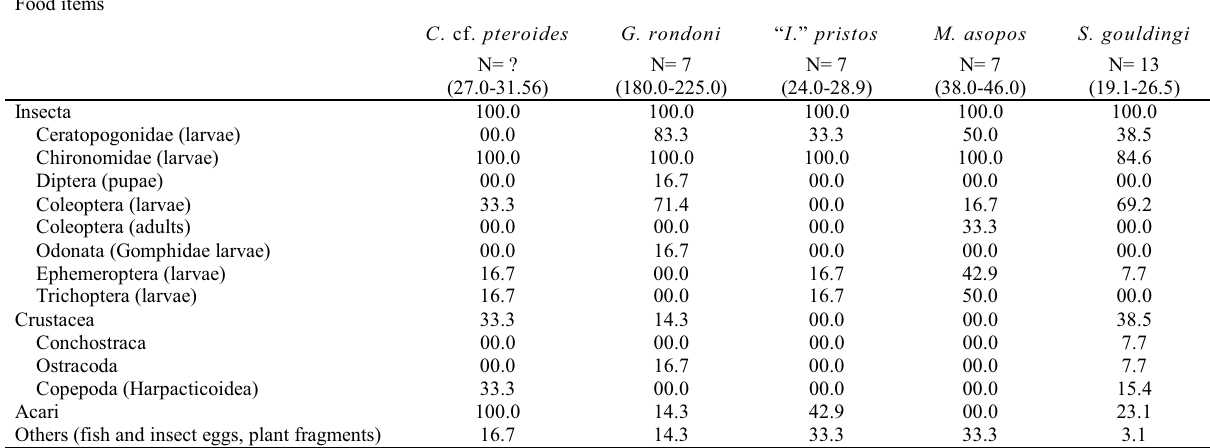
Table 1. Frequency of occurrence of major food types in the diet of five sand-dwelling fish species from a forest streamlet in central Amazonia during dry season. Numbers in parentheses are size range of examined specimens (standard length in mm; total length for G.